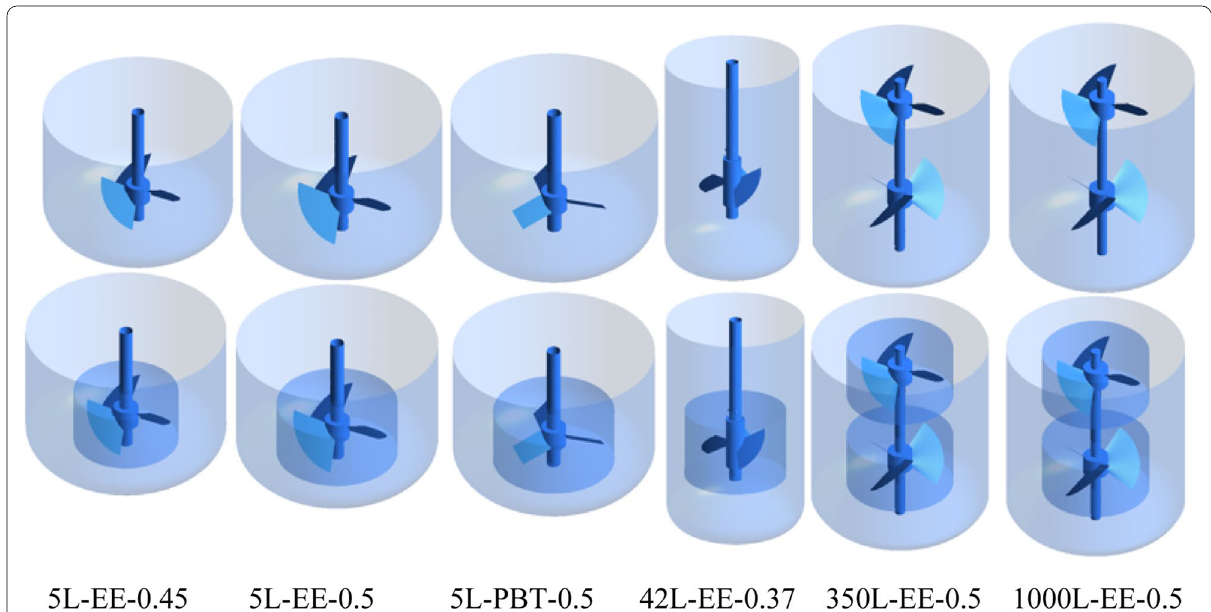
Fig. 1 Schematic diagram of the three-dimensional bioreactors and impeller zones for CFD simulation (the text at the bottom indicates the type of each bioreactor, namely, “bioreactor volume-impeller type-ratio of impeller diameter to tank